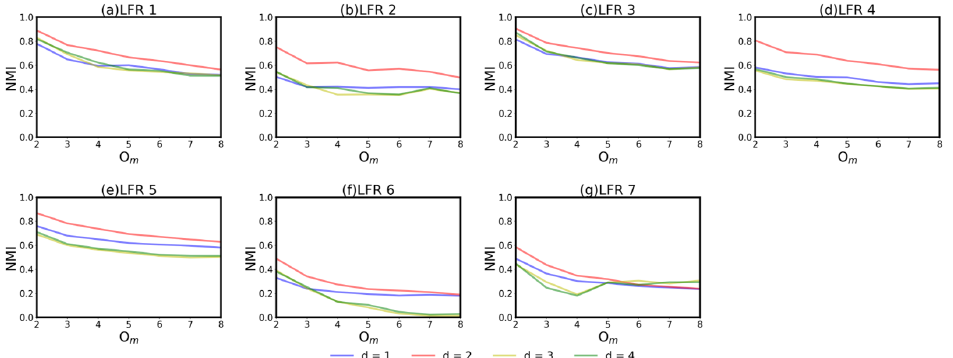
Figure 1. In the sub figure ( a – g ), the curves with different colors represent the NMI of LELP when d is